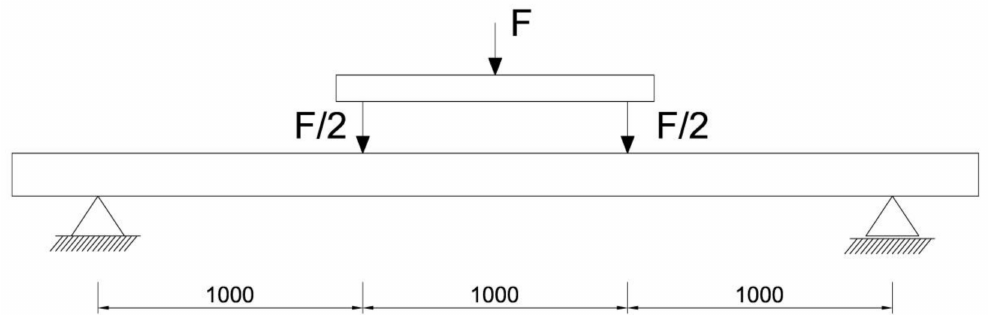
Figure 3. Static test of four-point bending (dimensions in mm).